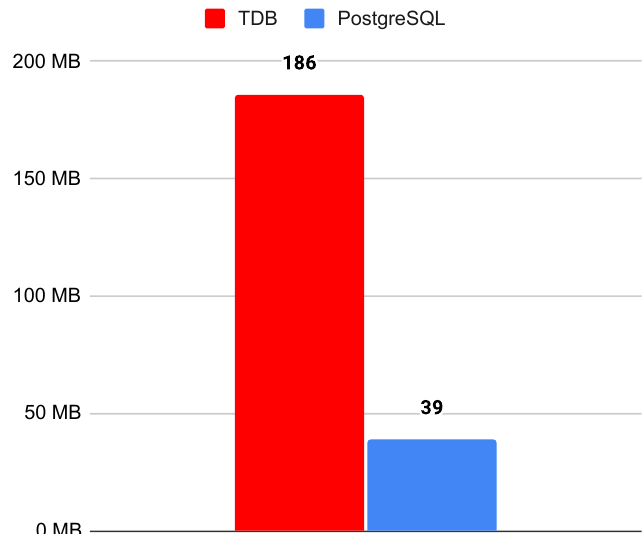
Figure 8. Memory space